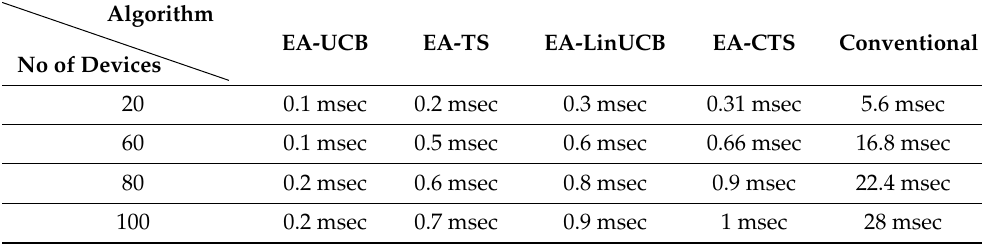
Table 2. Execution times of the compared